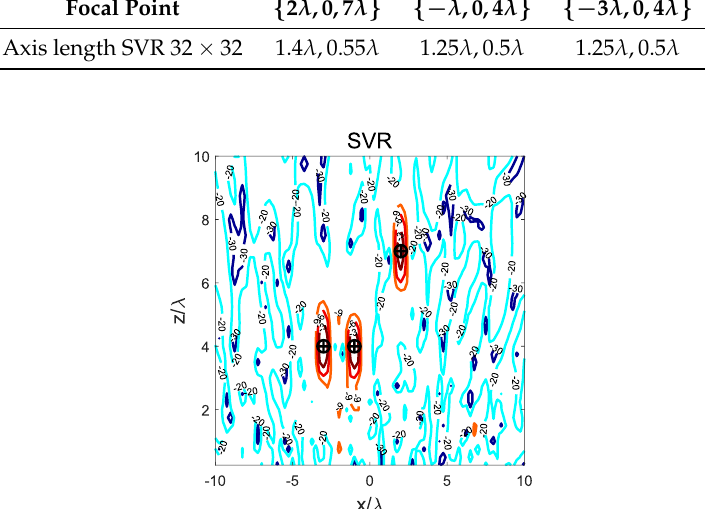
Figure 2. Example #1. Normalized near-field power density at y = 0 for the SVR method using a 32 × 32 element array. The symbols + and ◦ represent the focal and synthesized maximum points